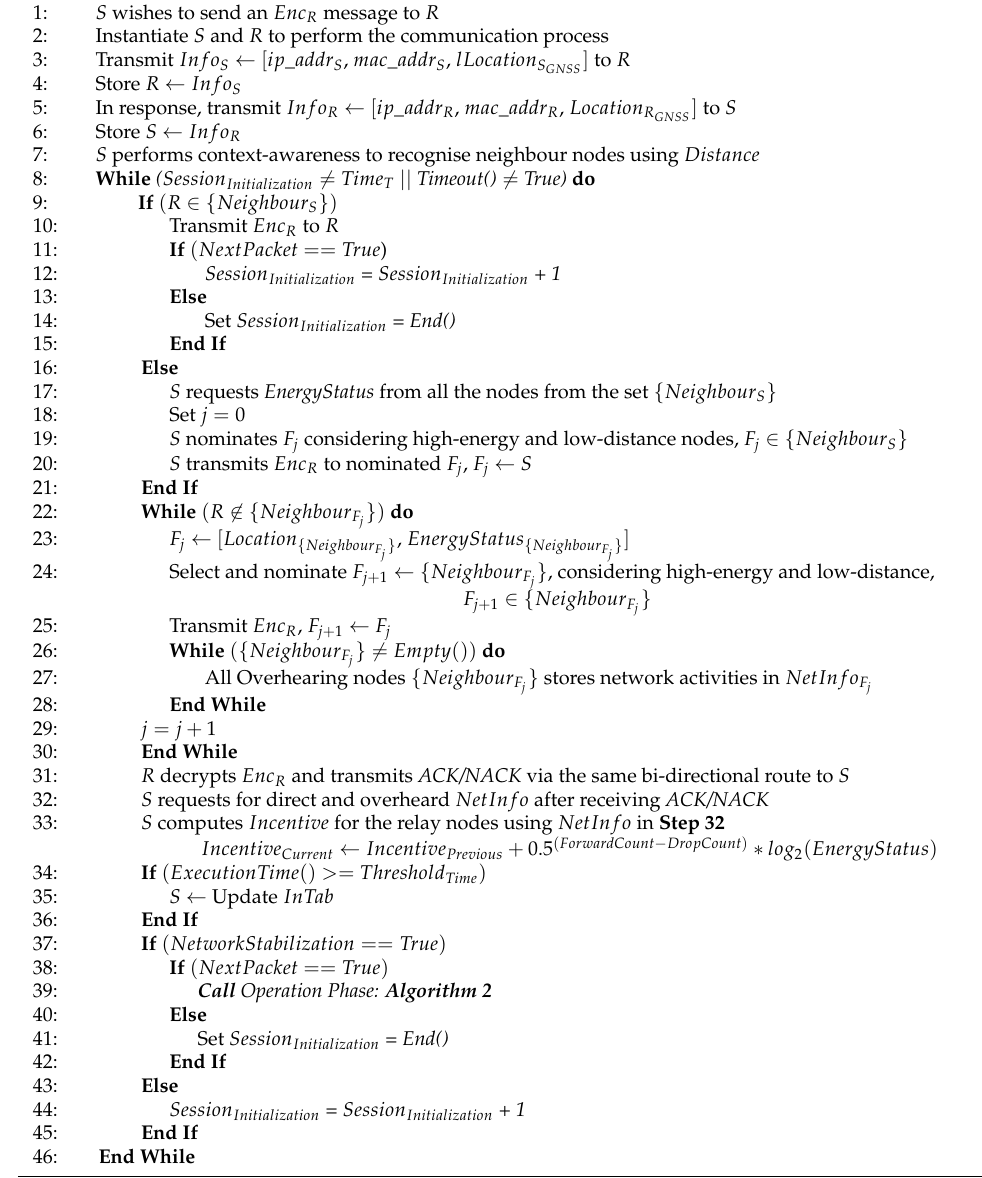
Algorithm 1 Initialization